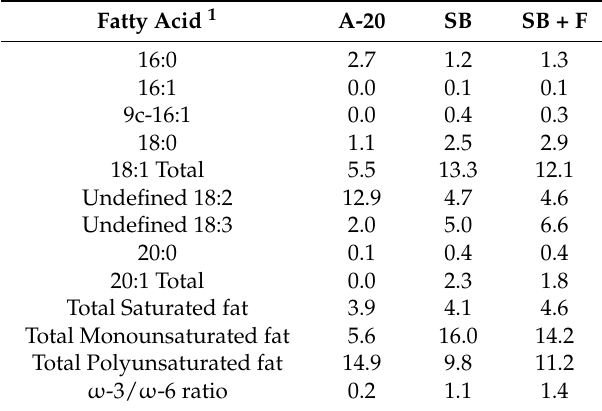
Table 2. Fatty acid composition in LNS products (g/100